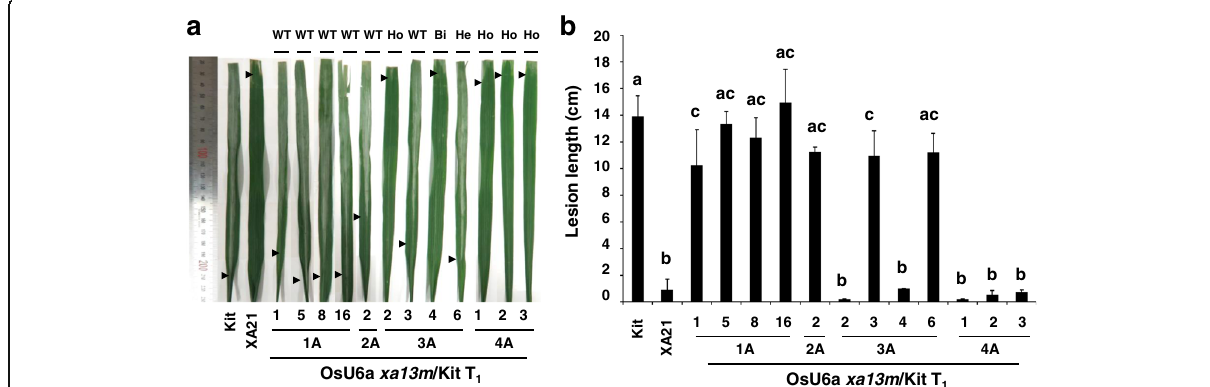
Fig. 4 CRISPR/Cas9-mediated mutagenesis in both Os8N3 alleles conferred enhanced resistance to Xoo . a Bacterial blight resistance phenotypes of the xa13 mutant rice lines (T 1 ). Rice plants 12 DAI with Xoo . From left to right: Kitaake (Kit), transgenic line (XA21, 7A-8) carrying Xa21 driven by the ubiquitin promoter, and transgenic lines (OsU6a xa13m /Kit, T 1 ) carrying the OsU6a:: xa13m-sgRNA /pHAtC construct. Arrowheads indicated the end of the lesion. WT; wild type: Ho; homozygous: Bi; bi-allelic: He; Heterozygous. b Lesion lengths measured 12 DAI in Kitaake, XA21, and OsU6a xa13m /Kit T 1 . Error bars in the graph represent standard error of at least three leaves from each plant. Letters indicate a significant difference at P < 0.050 by Tukey ’ s HSD